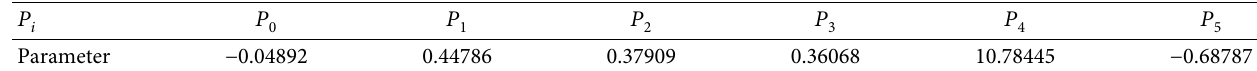
Table 3: Fitting parameters.